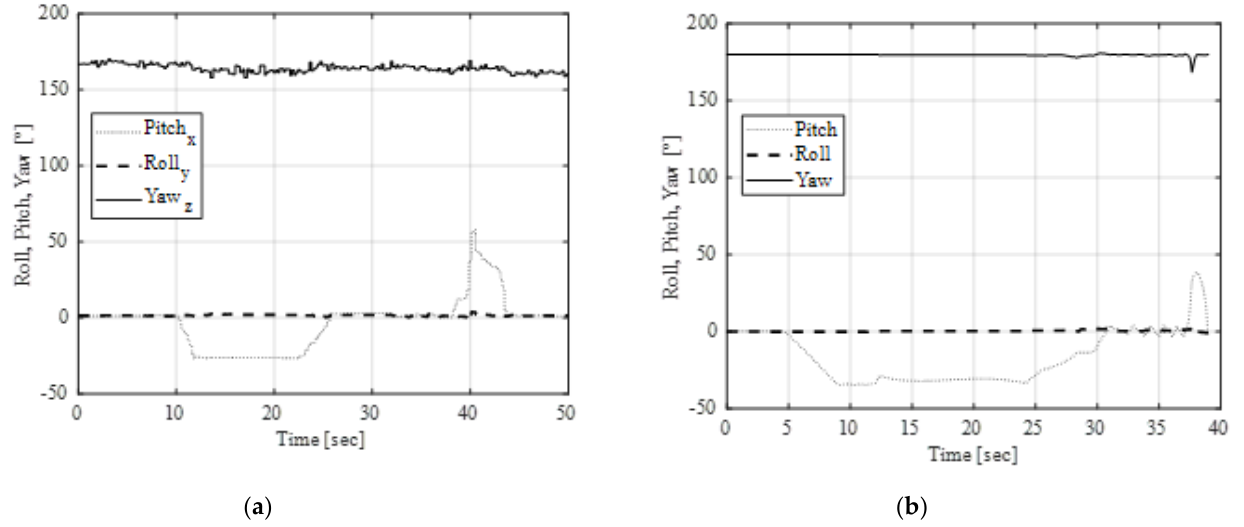
Figure 9. Experimental/numerical test of the dynamic behavior of the robot in Figures 6 and 7 in negotiating with the stepfield pallet: Roll, pitch and yaw ( a ) experimental and ( b ) numerical results.